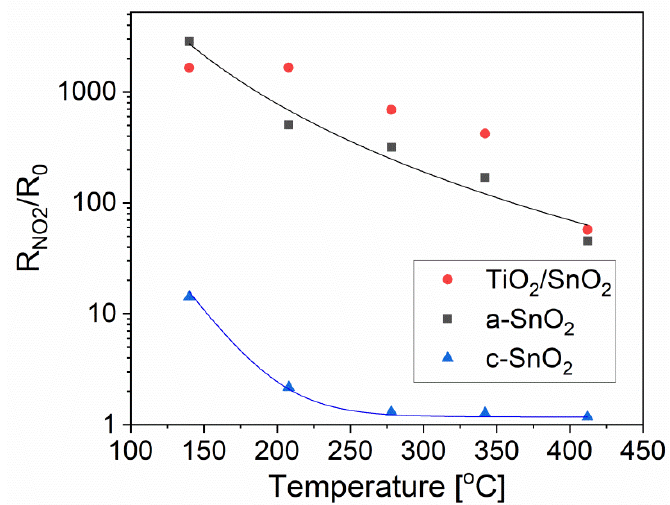
Figure 11. The R NO2 / R 0 responses to 20 ppm NO 2 of a-SnO 2 , c-SnO 2 and SnO 2 / TiO 2 thin films vs. operating temperature.